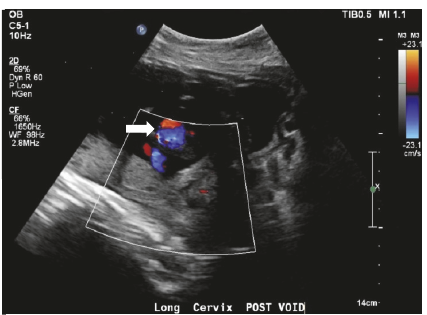
Figure 1: Follow-up ultrasound at 16 weeks and 6 days of gestation reveals a vascular malformation (arrow) at the lower uterine segment with swirling flow within the malformation consistent with a pseudoaneurysm.